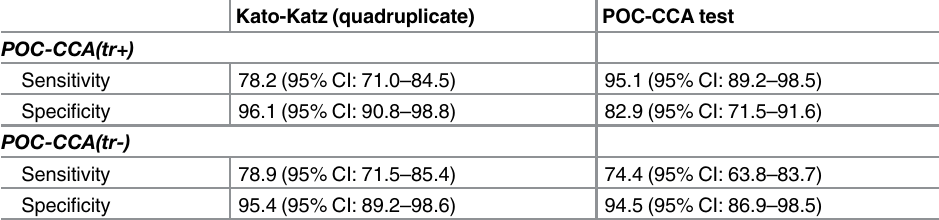
Table 2. Sensitivity and specificity of Kato-Katz and the POC-CCA test using a latent class